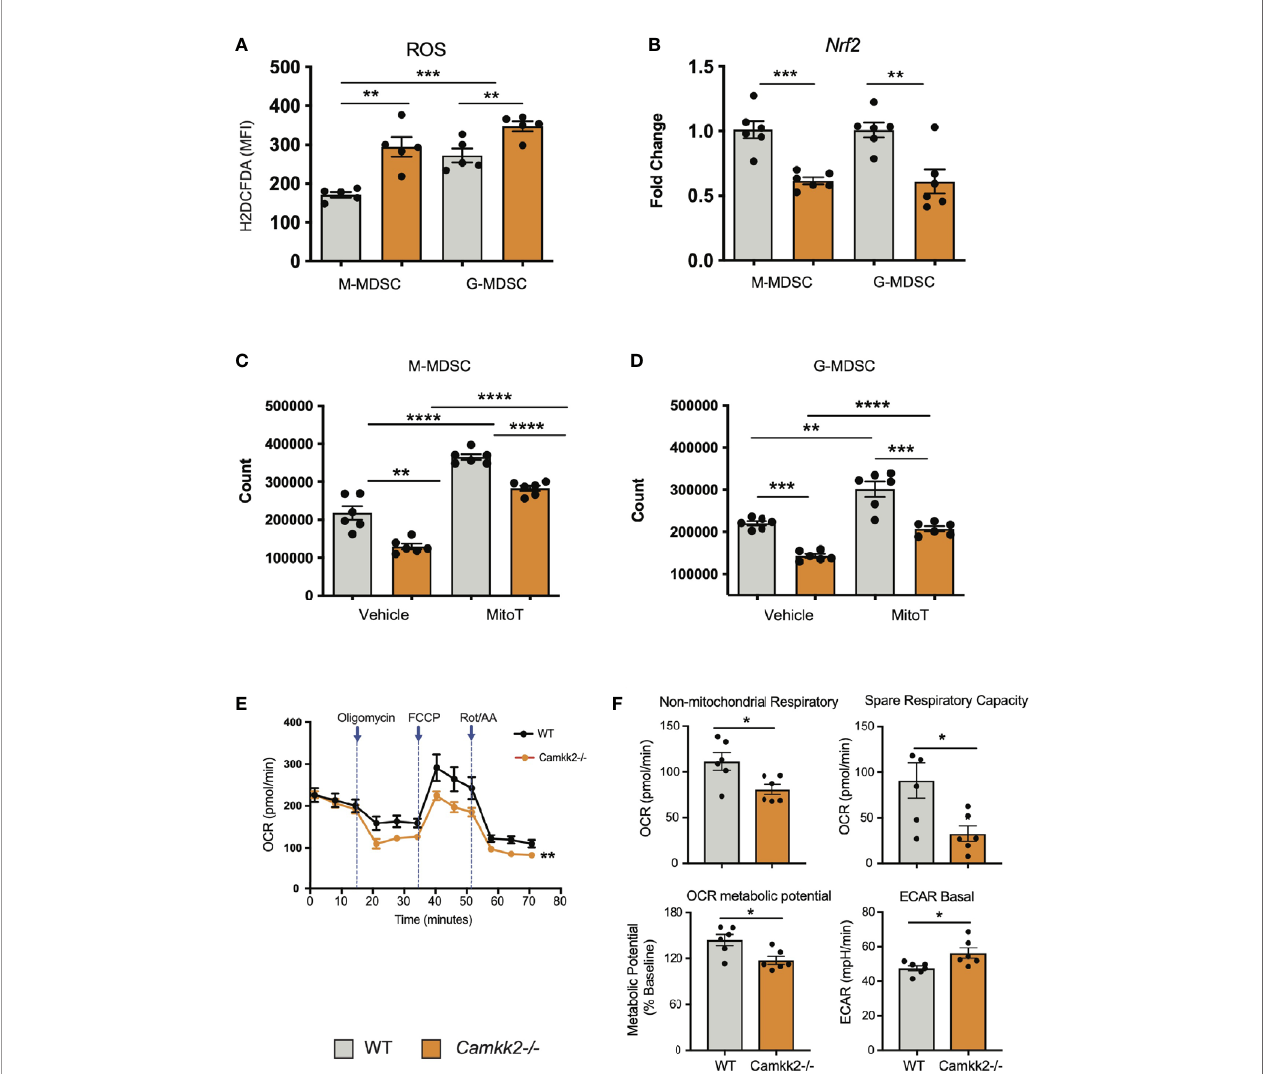
FIGURE 6 | Camkk2 de fi ciency increases reactive oxygen species (ROS) accumulation and impairs mitochondria functions in MDSC. MDSCs were generated from bone marrow nucleated cells of WT and Camkk2 -/- mice femurs. (A) MDSCs were identi fi ed according to the gating strategy described previously and ROS levels were evaluated by fl ow cytometry using H2DCFDA staining. (B) M-MDSC and G-MDSC were puri fi ed by sorting and Nrf2 expression was determined by qPCR. (C, D) Yield of M-MDSC and G-MDSC generated in the presence of 20 m M Mito Tempo, a mitochondrial ROS scavenger compound, added on Day 0 and Day 3. (E, F) Metabolic analysis of in vitro generated MDSC using Seahorse XF24 Analyzer. (E) OCR response to oligomycin, FCCP, and Rot/AA. (F) Quanti fi cation of non- mitochondrial respiratory, spare respiratory capacity, OCR metabolic potential, and ECAR basal level calculated by Agilent Seahorse Wave Software. Combined from two experiments. N=6. The experiment was repeated twice. *, **, ***, and **** refer to p<0.05, p< 0.01, p<0.001, p<0.0001,